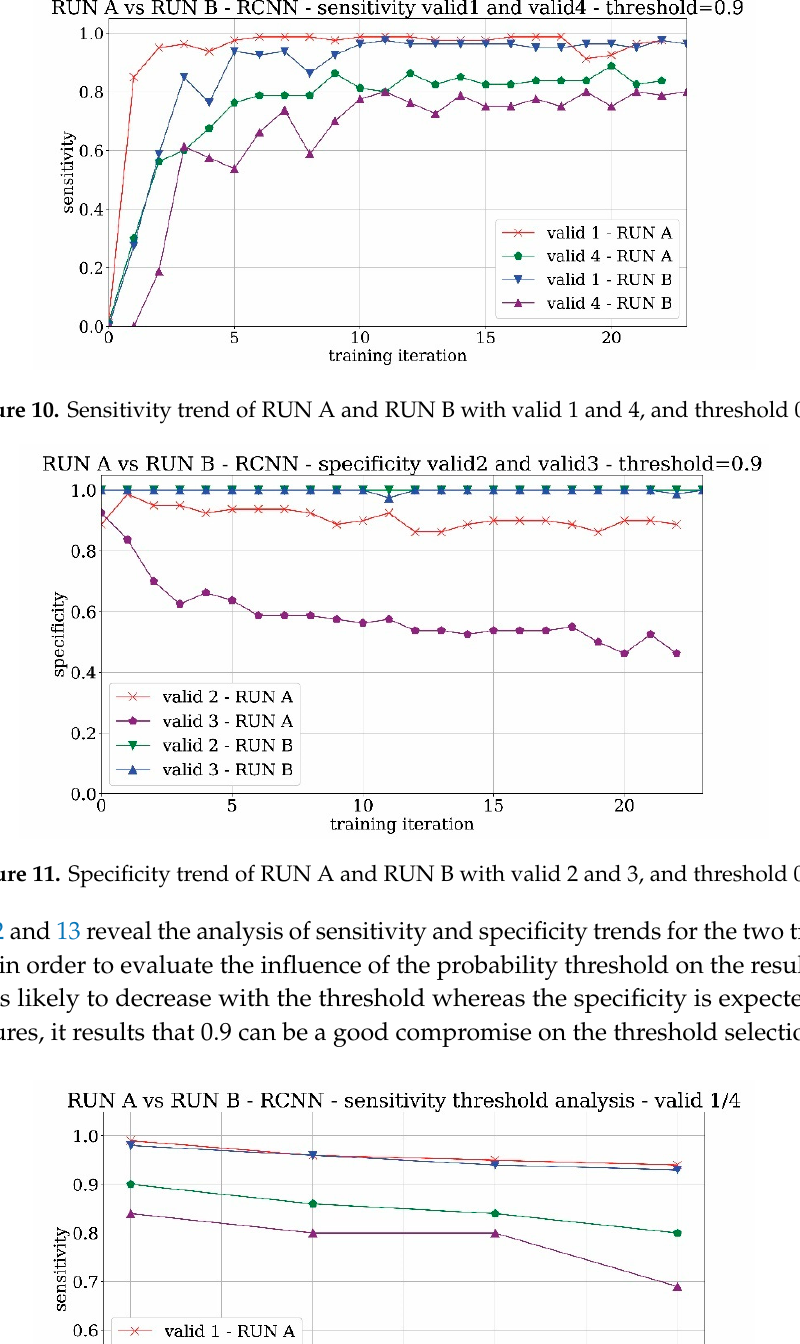
Figure 13. Specificity threshold analysis for RUN A and RUN B with valid 2 and 3. The third training RUN C which was attempted is based on the SSD network, while keeping fixed the training dataset (including negative matches). The results of the comparison between the RCNN network and the SSD network are shown in Figures 14 and 15. What can be seen is that in positive cases the SSD network provides better values of sensitivity at least for the valid 4 set (Figure 13). However, from a visual inspection, it turns out that the images which are detected only by the SSD network are usually very poor-quality images or even drawings and therefore not suitable for the photogrammetric extraction. In terms of specificity, from Figure 15 it turns out that the values for both networks are high. Especially for the RUN B the values are very close to the ideal value of the unit. On the other hand, from Figure 15 it results that there is a specificity degradation for the SSD network. Even though, the specificity degradation seems small—around 2%—it is worth noting that in realistic scenarios the amount of negative images is huge and having 2% of false positives may be incredibly costly for the end-user activity.